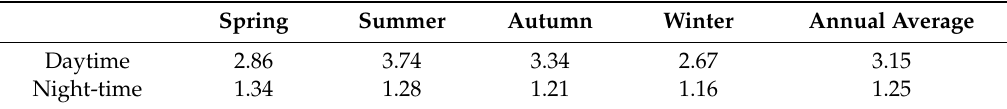
Table 5. The diurnal and seasonal SUHII values of 44 South American cities. Spring